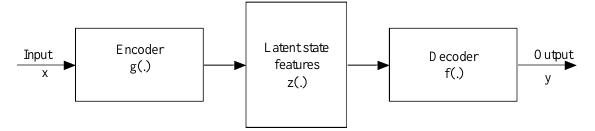
Figure 6. A simple encoder-decoder architecture.